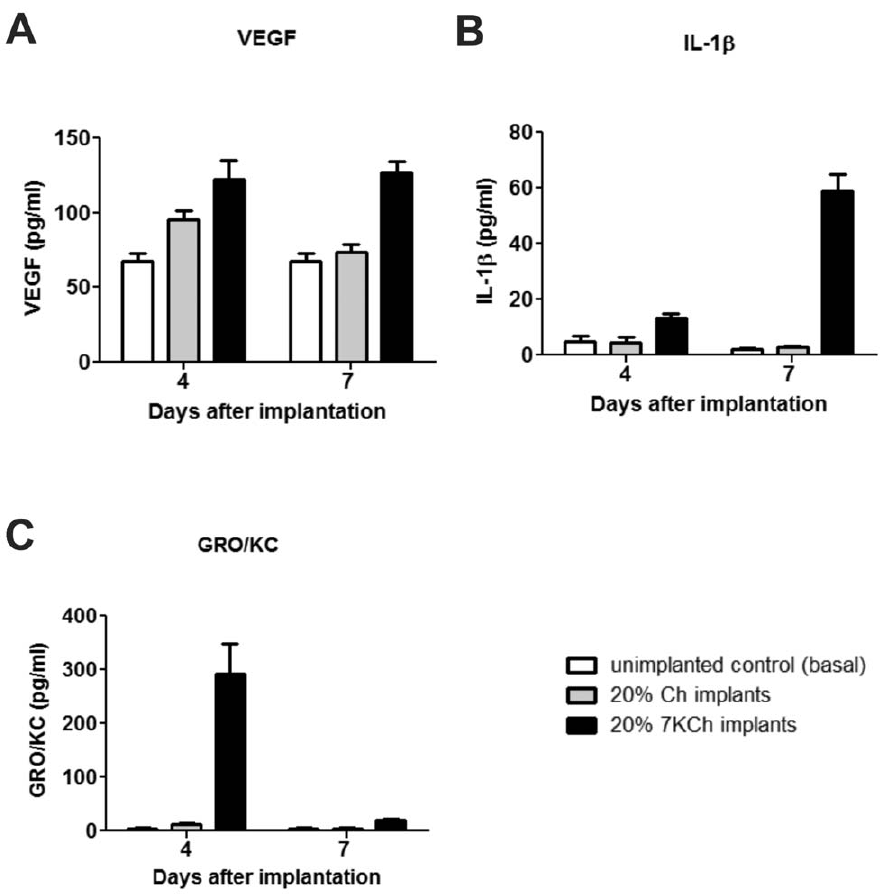
Figure 9. Quantification of VEGF, IL-1 b and GRO/KC in AH 4 and 7 days after implantation. AH from eyes of un-implanted (control) and implanted with 20% Ch and 7KCh wafers were analyzed for cytokine levels 4 and 7 days post implantation, as described above. A. VEGF. B. IL-1 b . C. GRO/KC.